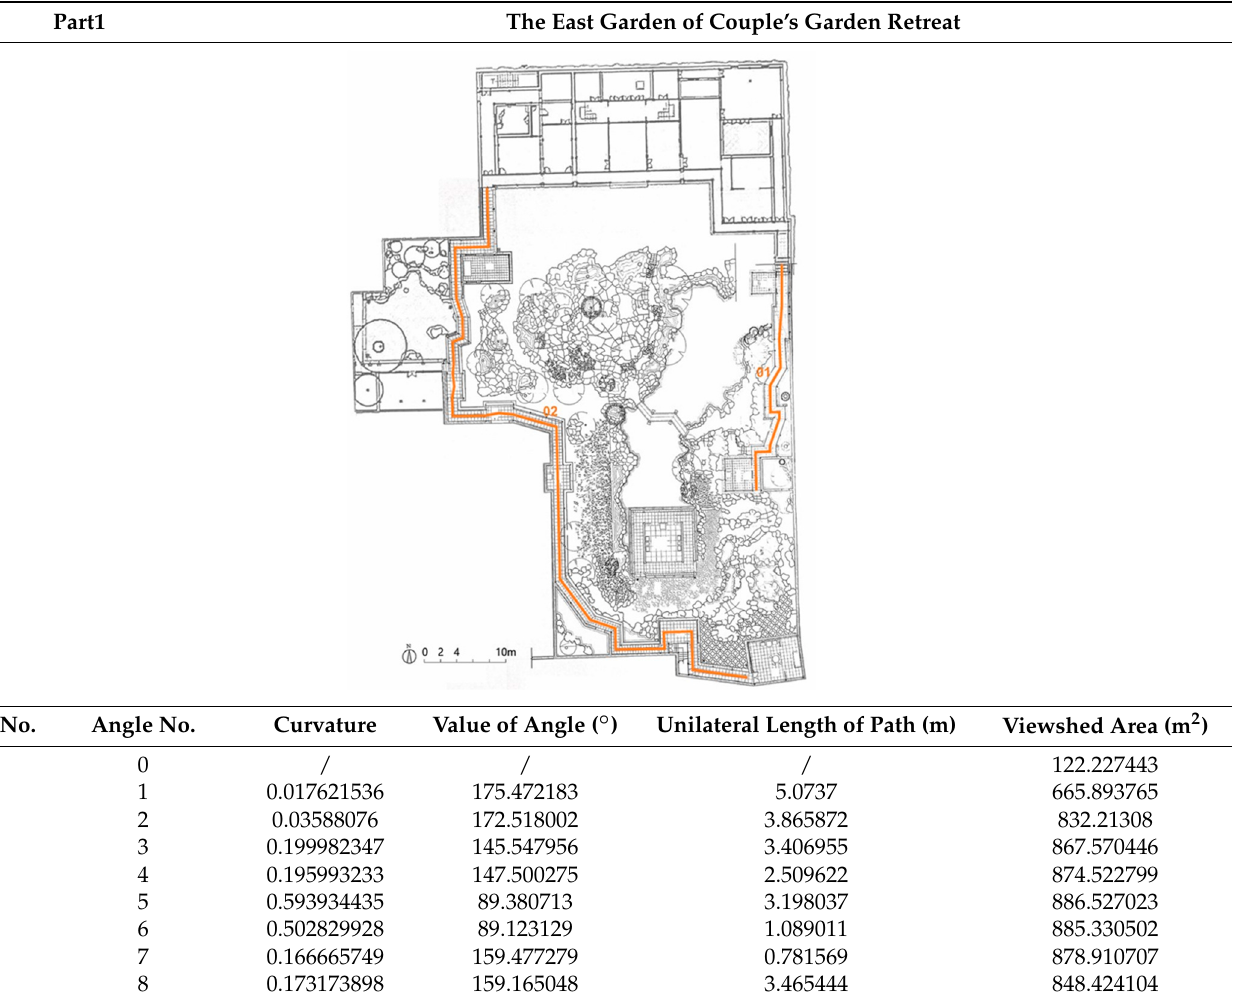
Table A18. Couple’s Garden Retreat, corridor.